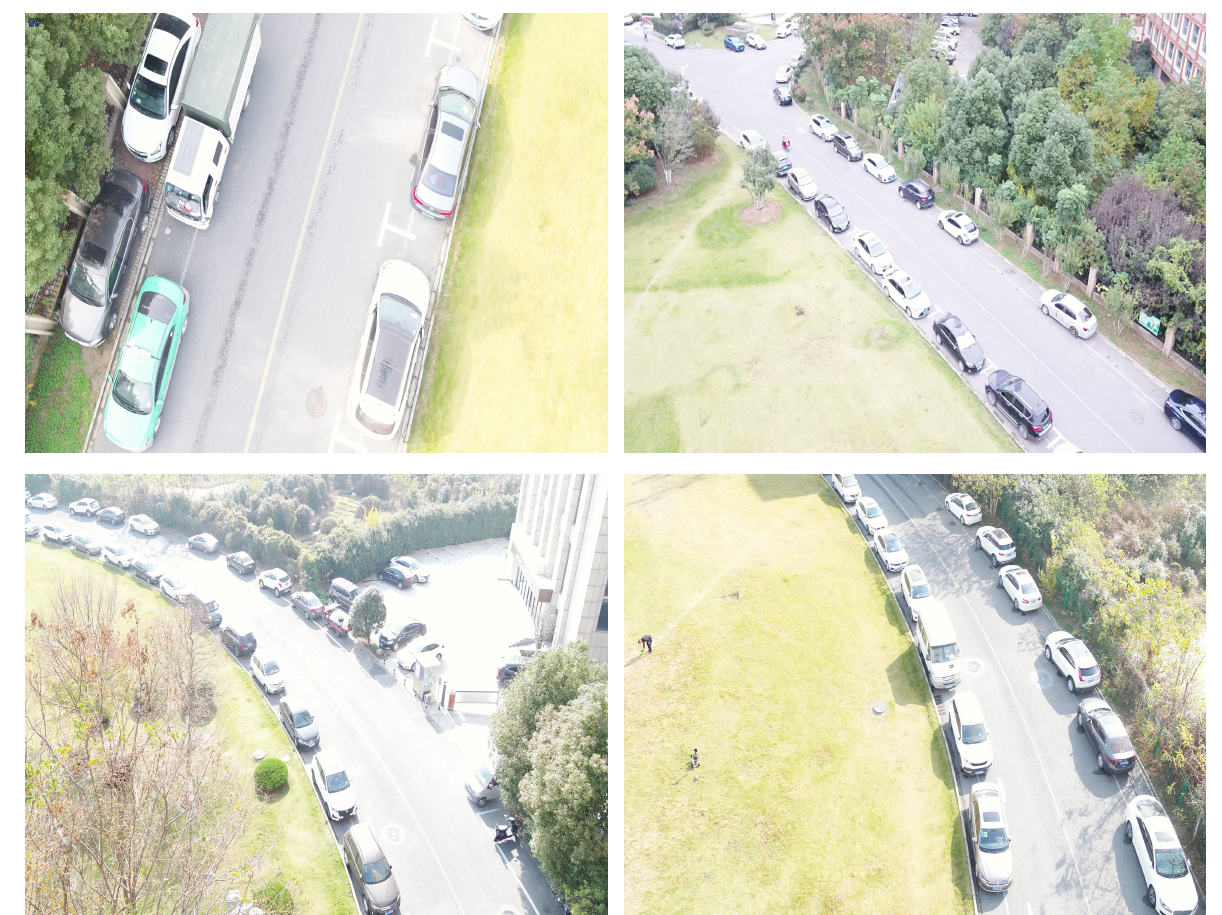
Figure 8. Some selected unprocessed images of our self-collected